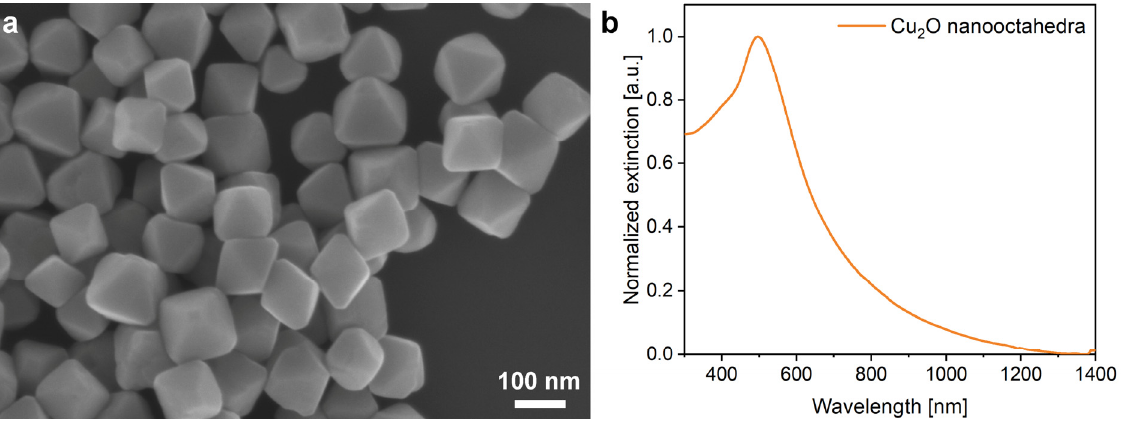
Figure 2. Cu 2 O nanoparticles stored in ethanol. ( a ) SEM micrograph of the nanoparticles drop dried on Si; ( b ) Extinction of the nanoparticles suspended in ethanol.